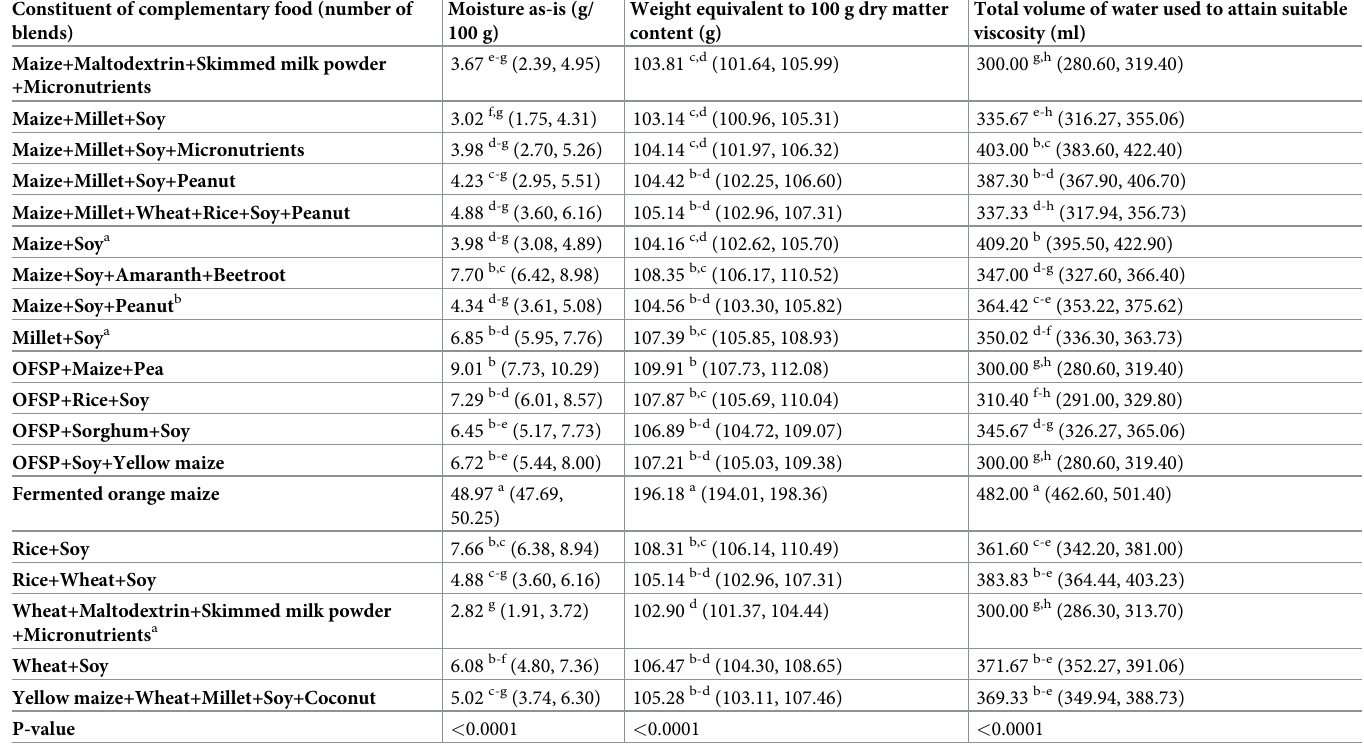
Table 1. Moisture and weights taken equivalent to 100 g dry matter content.